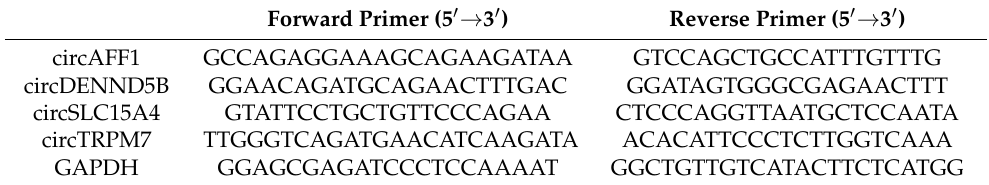
Table 2. Primers used for qPCR